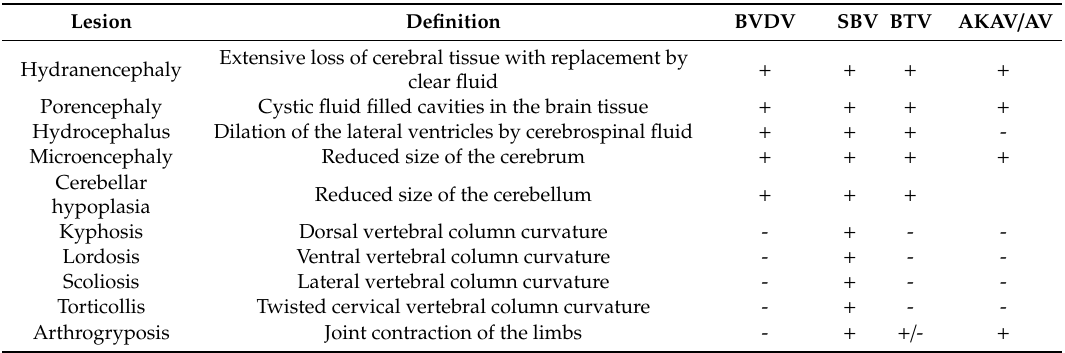
Table 3. Summary of some of the most common central nervous and musculoskeletal lesions following in utero infection with bovine virus diarrhoea virus (BVDV), SBV, BTV, Akabane virus (AKAV), or Aino virus (AV). Adapted from